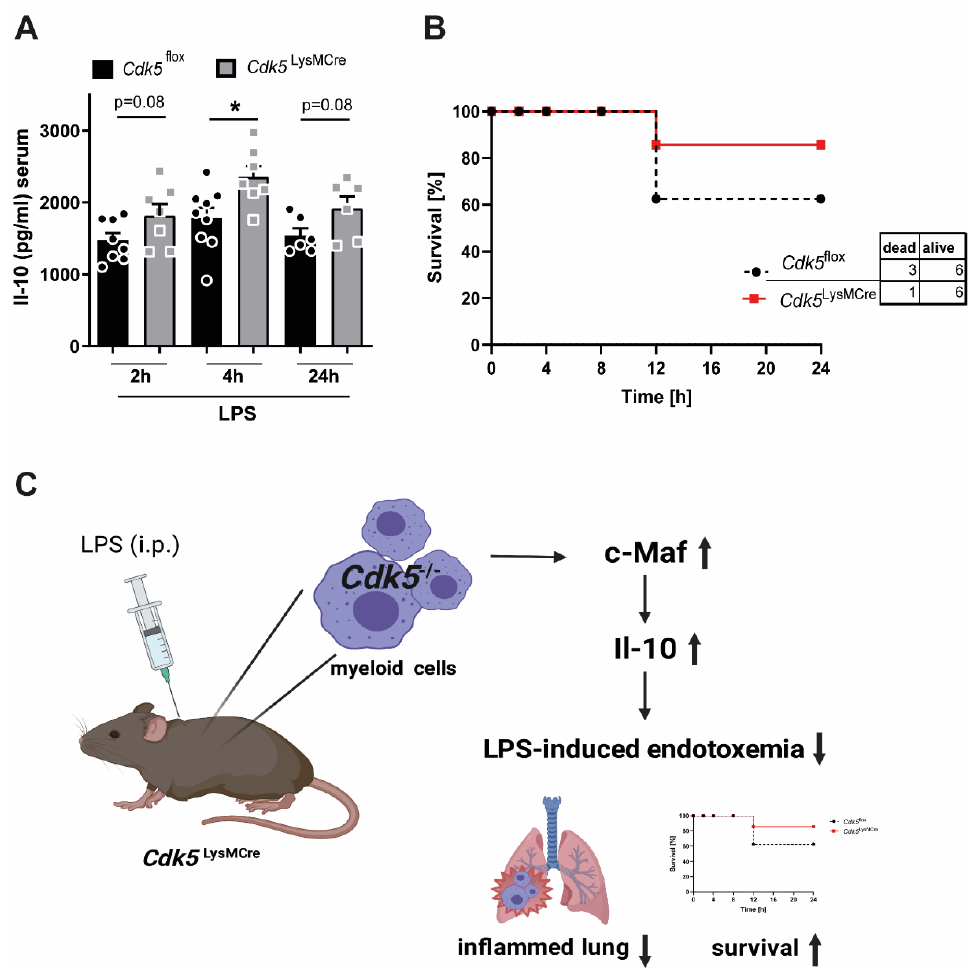
Figure 4. Myeloid-specific Cdk5 deletion increases systemic Il-10 plasma levels, which leads to increased survival of Cdk5 LysMCre mice during LPS-induced endotoxemia. ( A ) Il-10 in plasma of Cdk5 flox and Cdk5 LysMCre mice was detected by ELISA during endotoxemia (LPS 15 mg/kg) after 2 h, 4 h and 24 h. ( B ) Survival of Cdk5 flox (n = 9) and Cdk5 LysMCre (n = 7) mice was monitored for 24 h during LPS-induced endotoxemia. ( C ) Schematic representation showing that the absence of Cdk5 in macrophages results in elevated c-Maf and Il-10 levels, thus contributing to an ameliorated anti-inflammatory response during endotoxemia. Created with BioRender.com. Results are depicted as mean ± SEM. Statistical analysis were performed by ( A ) a normality test, followed by a two-tailed unpaired Student’s t test, ( B ) Kaplan–Meier (Chi-square) p = n.s.; * p < 0.05.